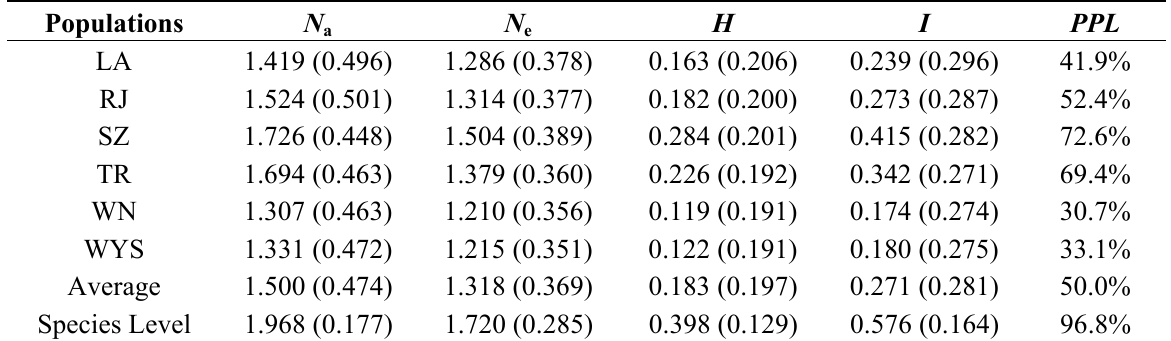
Table 1. Genetic diversity within the populations of C. tsoongiana